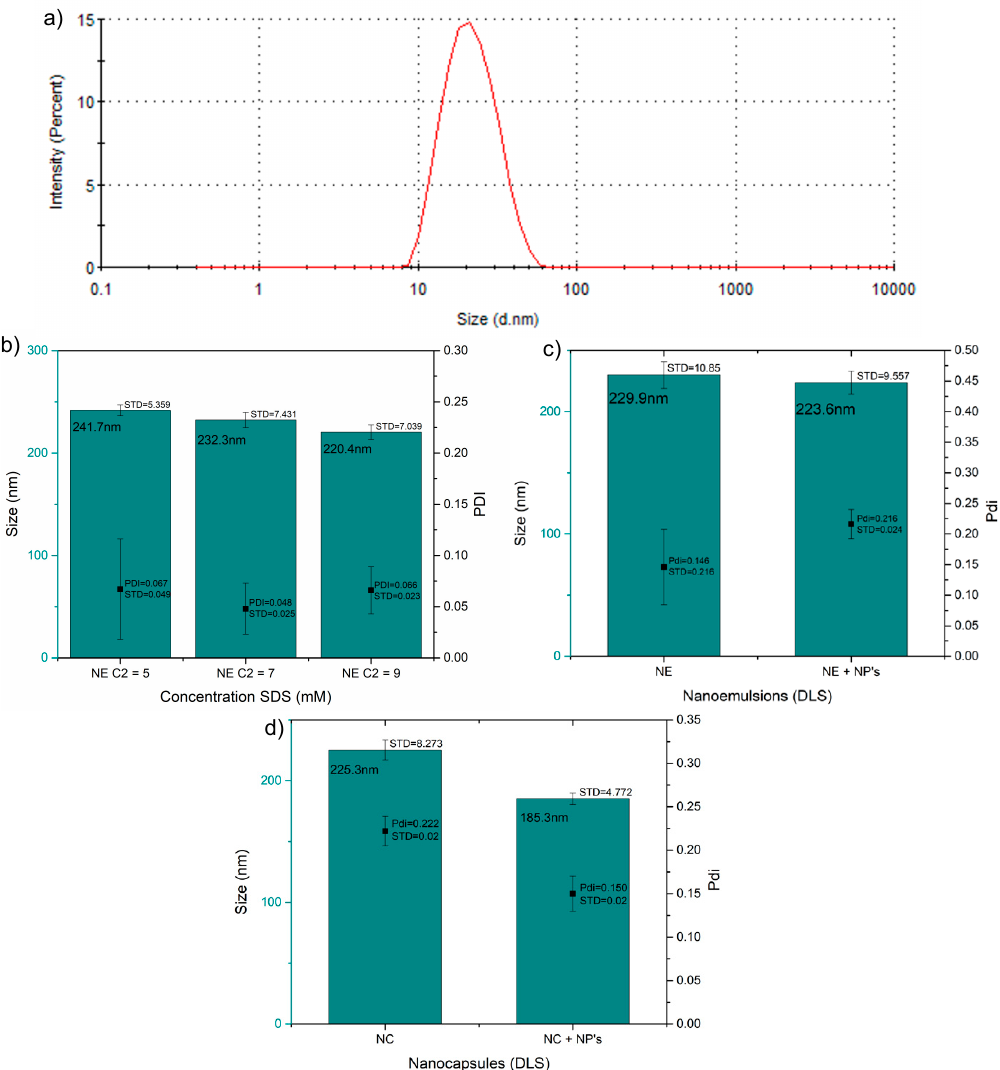
Figure 2. Hydrodynamic diameter values of the nanoparticles, emulsions and capsules. ( a ) Hydrodynamic diameter distribution of the iron carbide@iron oxide nanoparticles (NP´s) in toluene. ( b ) Hydrodynamic diameter and PDI of the uncoated nanoemulsion (NE) without nanoparticles at different concentrations. ( c ) Hydrodynamic diameter and PDI of the uncoated nanoemulsions with and without ICIONPs within the micelles. ( d ) Hydrodynamic diameter and PDI of chitosan coated nanocapsule (NC) with and without ICIONPs within.